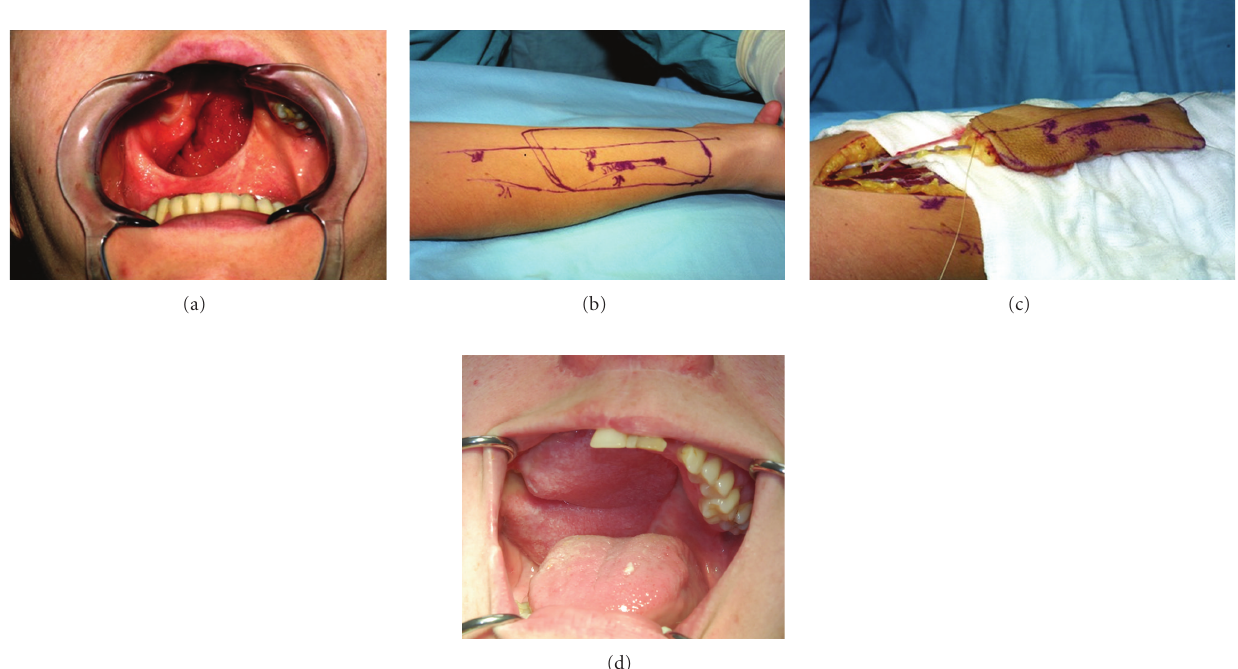
Figure 5: (a) Postoperative defect after partial maxillectomy due to low-grade mucoepidermoid carcinoma of the hard palate in 28-year-old female patient. (b) Radial forearm free flap designed. (c) Radial forearm free flap prepared for palatal reconstruction. (d) Result after 8 years following reconstruction of the palate by radial forearm free